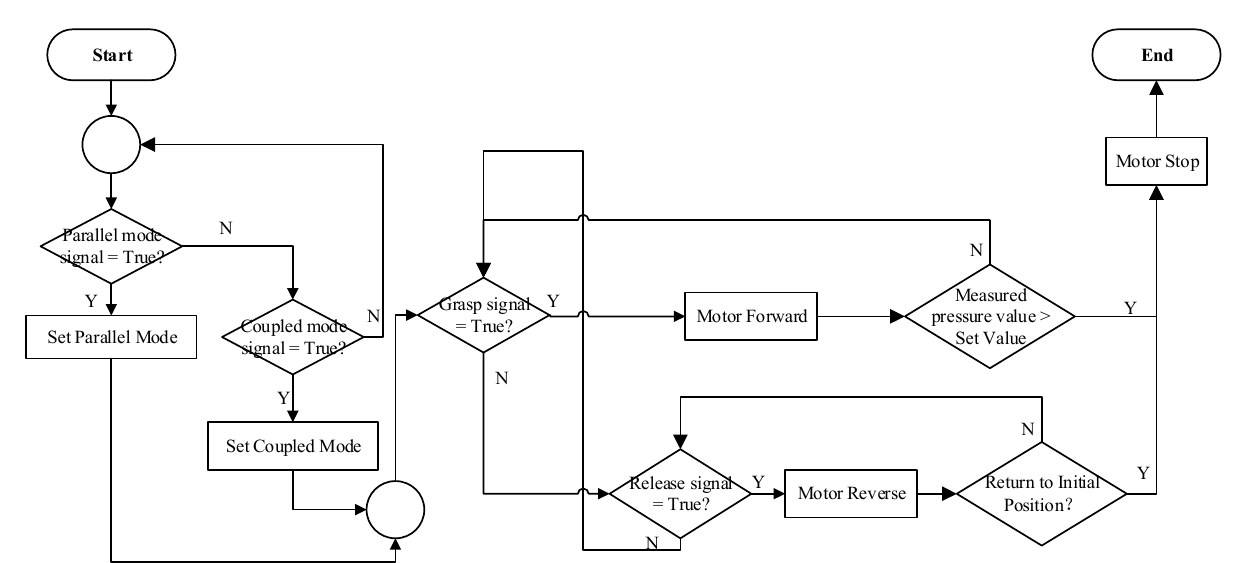
Figure 19. Control algorithm of the ESMGM robot hand system.